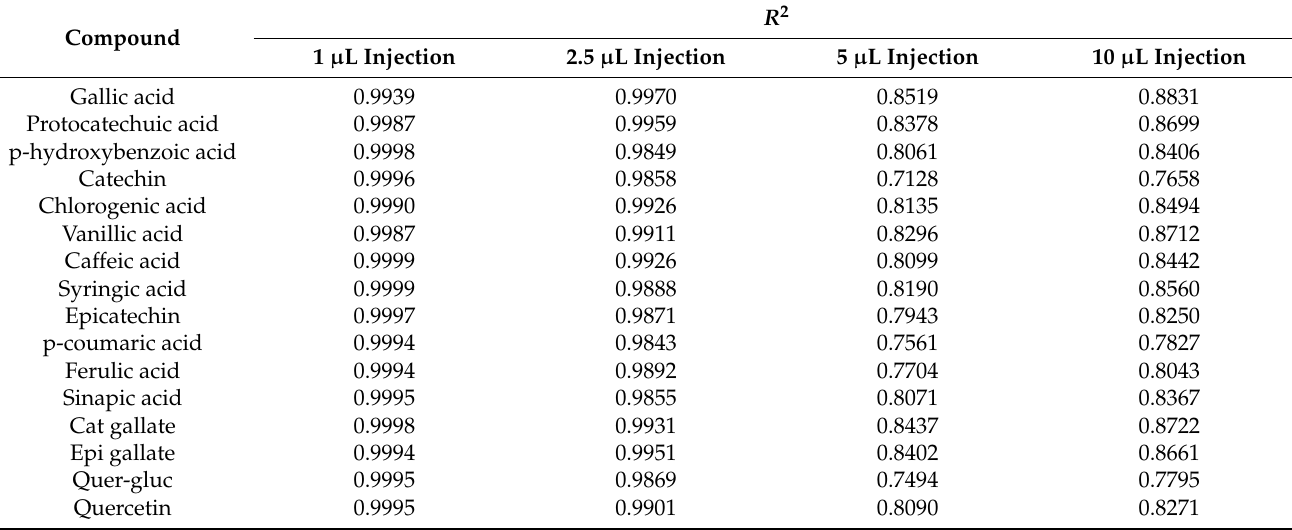
Table A2. Linear regression study for injection volumes for LC-MS/MS method for measured